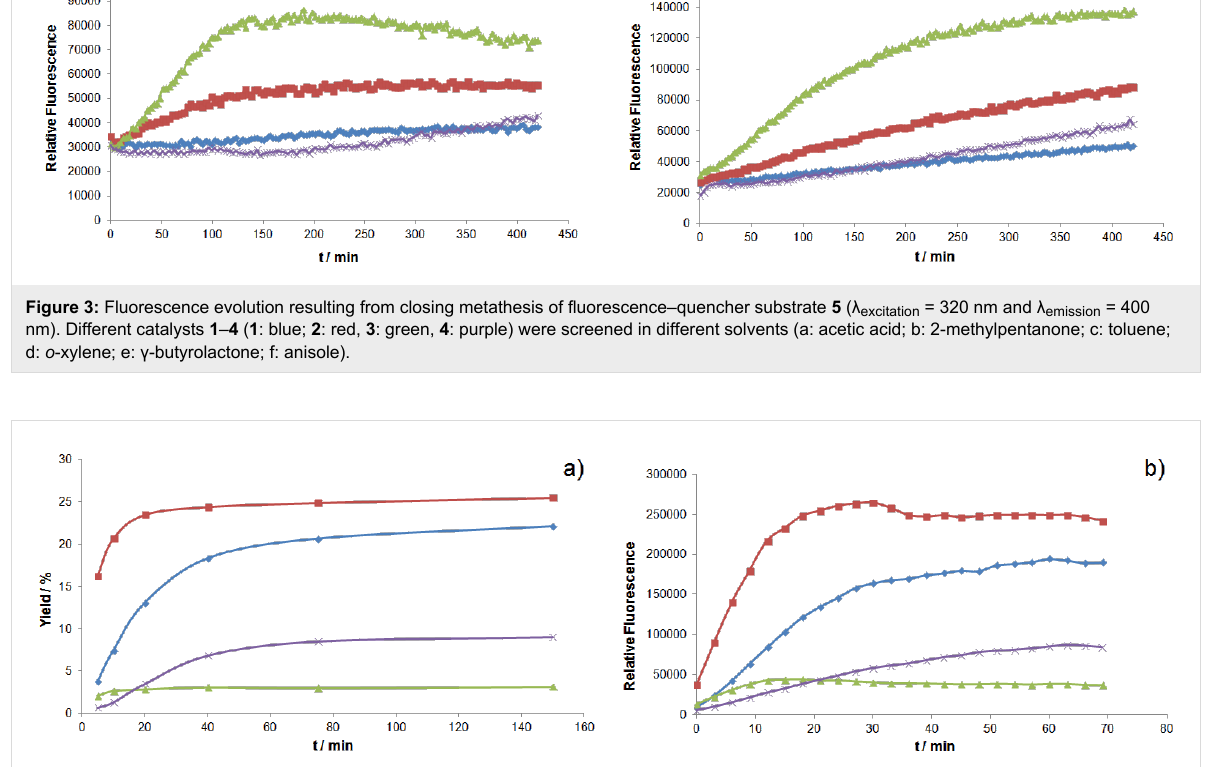
chemical shifts are reported in ppm (parts per million). Electro- spray ionization mass spectra (ESIMS) were recorded on a Bruker FTMS 4.7T bioAPEX II spectrometer. HRMS was